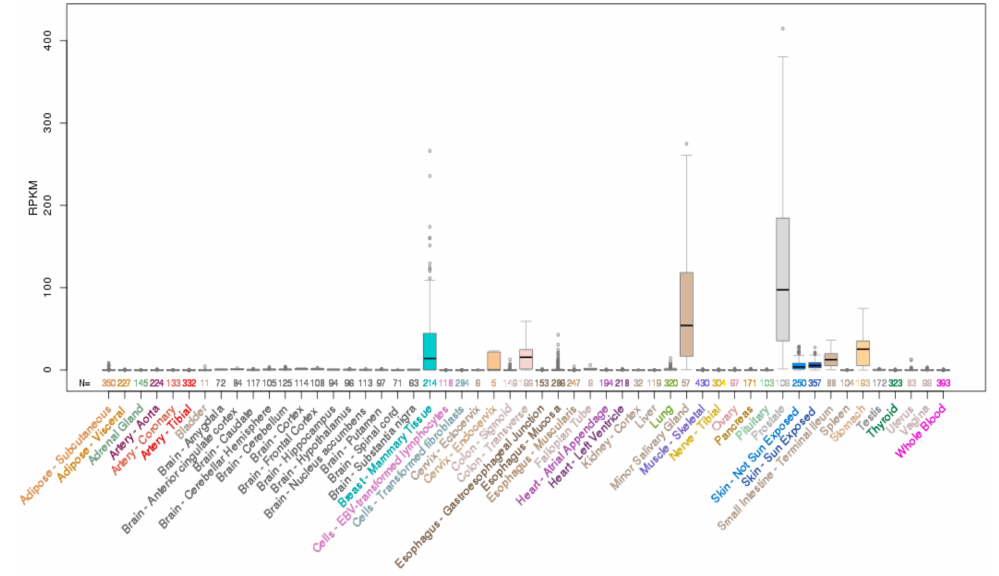
Figure 9. Expression of SPDEF mRNA across normal human tissues. Data obtained from UCSC genome